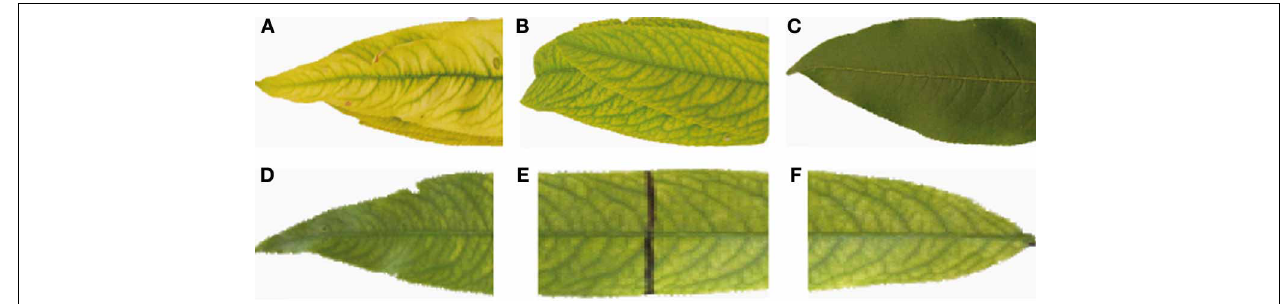
and 0.1% surfactant; (C) Positive control: Fe-sufficient leaves taken in the same position in the shoot but from a Fe-sufficient tree; (D) distal part of an Fe-treated leaf; (E) middle part of an Fe-treated leaf, showing the black line delimiting the treatment area; and (F) basal part of an Fe-treated leaf.